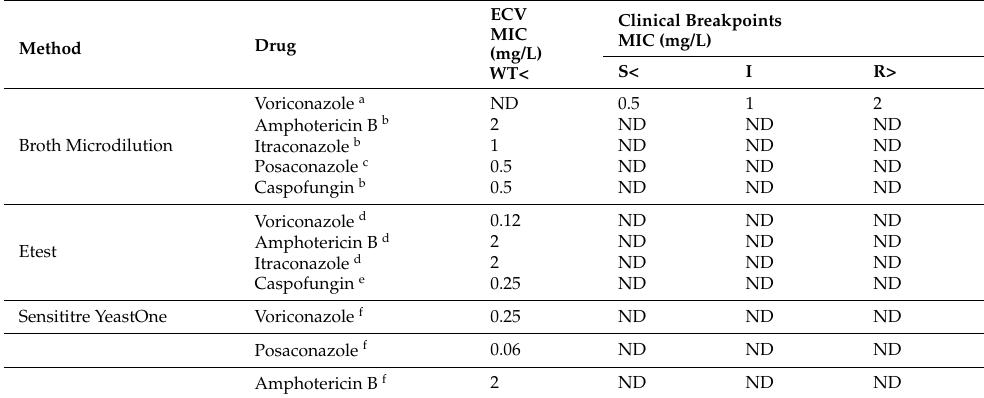
Table 1. Antifungal epidemiological cutoff values and clinical breakpoints for Aspergillus fumigatus using broth microdilution, Etest and Sensititre YeastOne